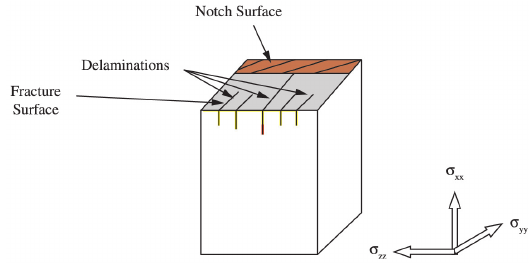
Figure 8. Geometry of a notch with directions of stresses σ